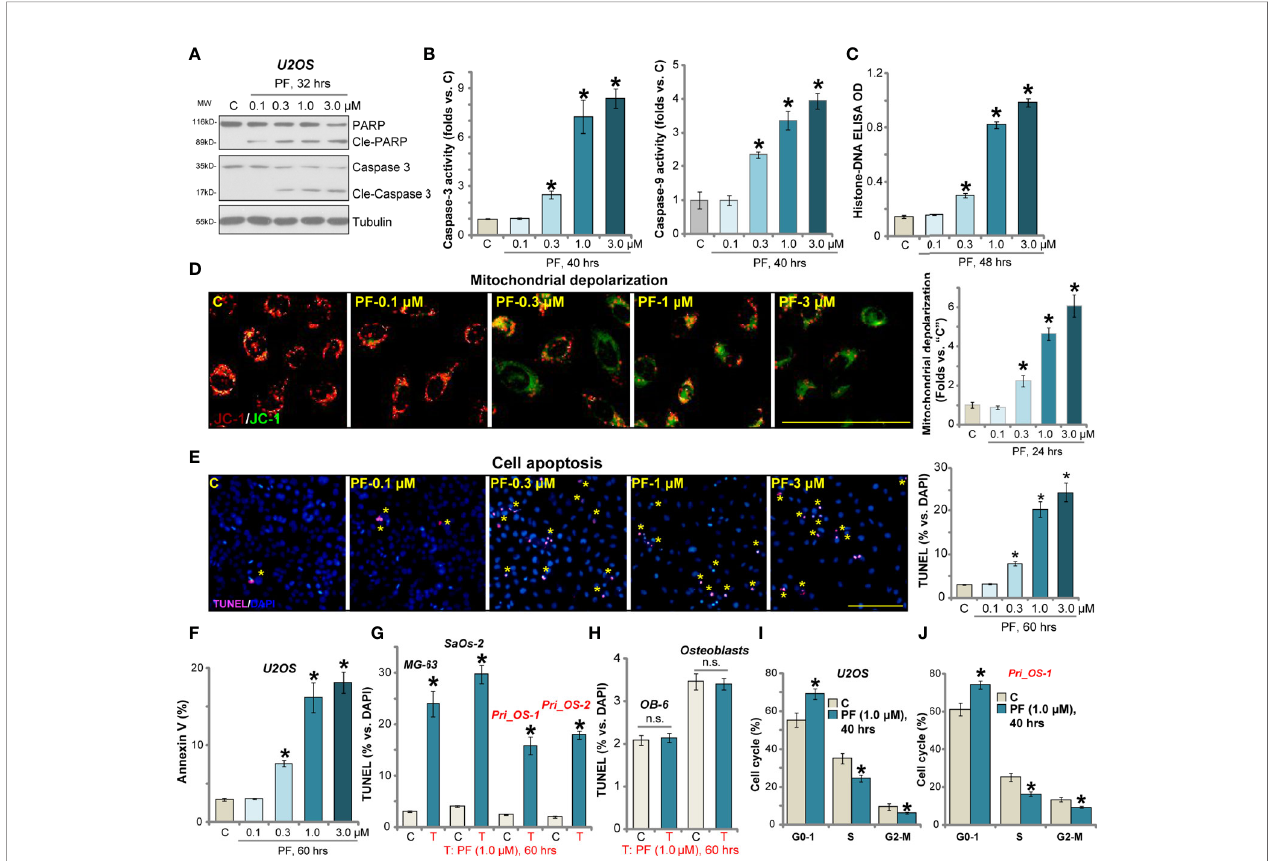
FIGURE 2 | PF-06409577 induces apoptosis activation and cell cycle arrest in human OS cells. U2OS cells (A – F) , MG-63 cells, SaOs-2 cells (G) , primary human OS cells ( “ Pri_OS-1/-2 ” ) (G) , OB-6 cells ( “ OB-6 ” ) (H) , or primary human osteoblasts ( “ Osteoblasts ” ) (H) were treated with applied concentration of PF-06409577 ( “ PF ” ) for indicated time periods, caspases activation and cell apoptosis were tested by the assays mentioned in the text. U2OS cells (I) or the primary human OS cells ( “ Pri_OS-1 ” ) (J) were treated with PF-06409577 ( “ PF ” , 1 m M, 40 h), cell cycle distribution was tested by PI-FACS, and results were quanti fi ed. For each assay, n = 5 ( fi ve replicate wells/dishes). Data were presented as mean ± standard deviation (SD). * p < 0.05 vs. “ C ” cells. “ n.s. ” stands for non-statistical difference. Experiments were repeated three times, and each time similar results were obtained. Scale bar = 100 m m (D, E)